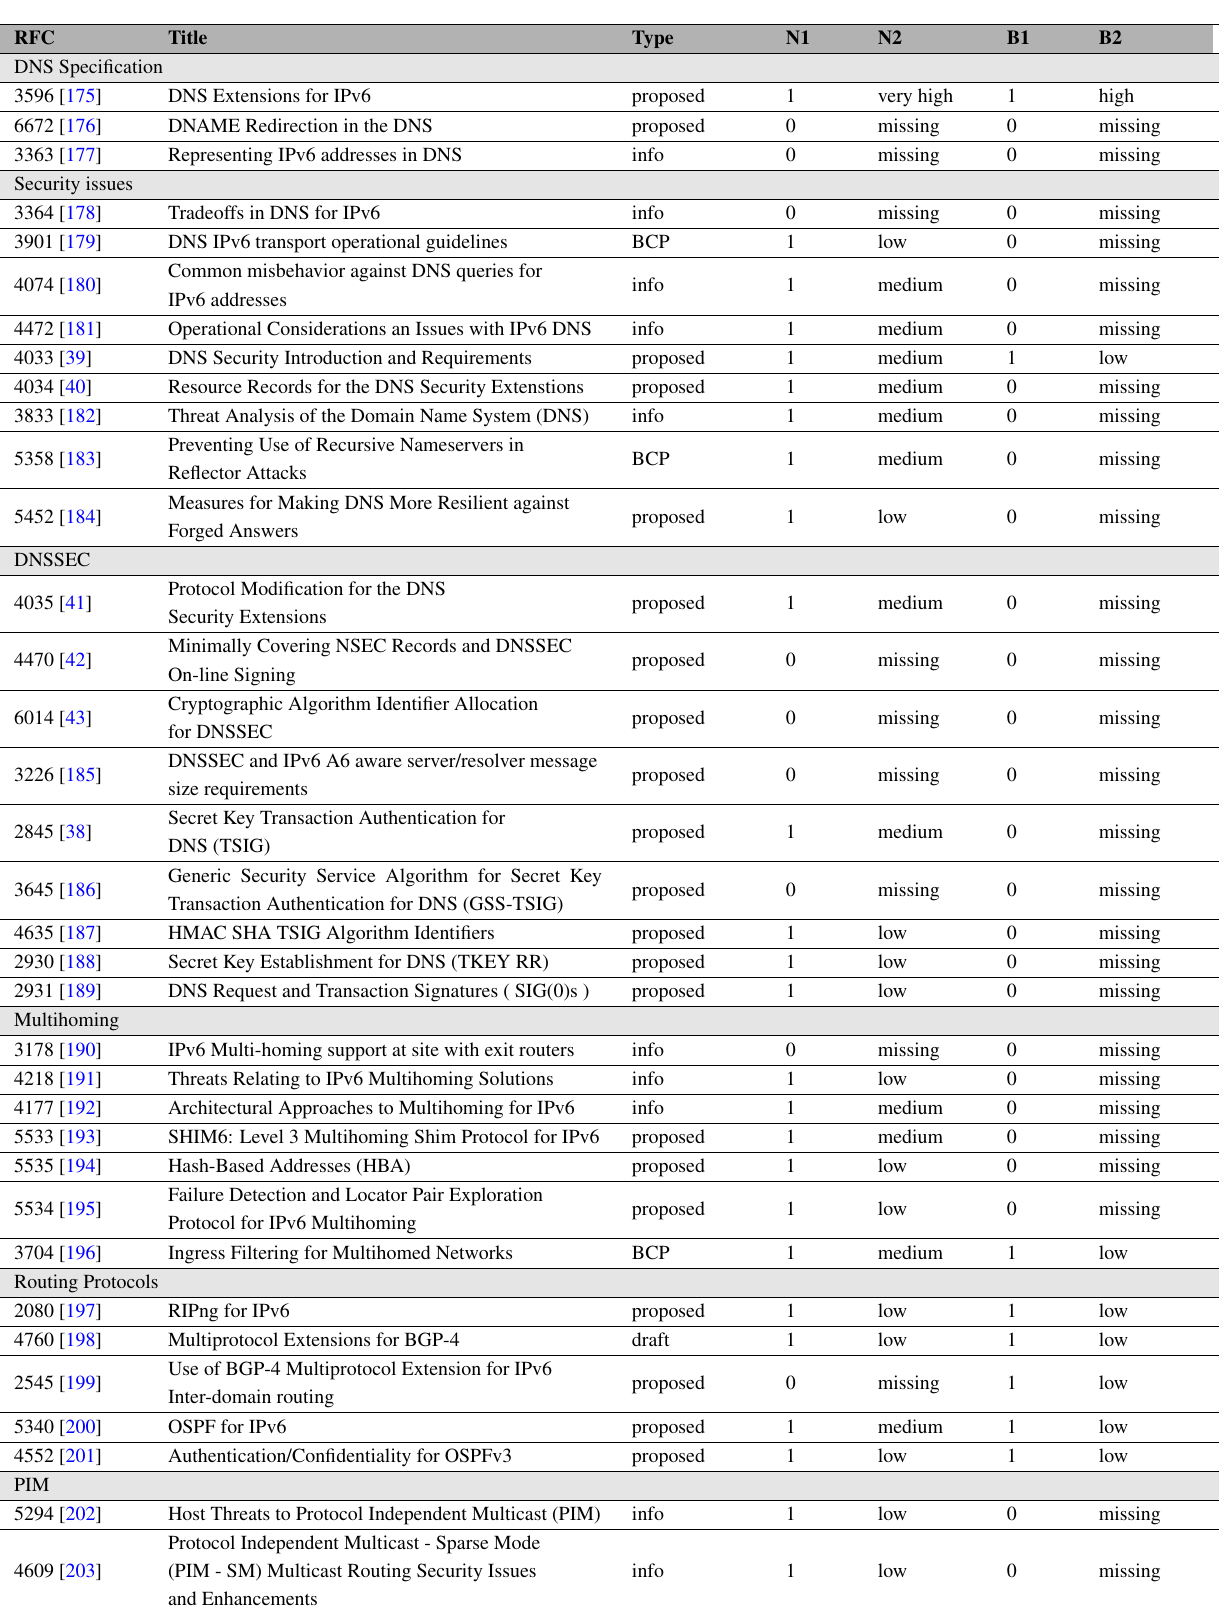
Table A5. RFCs on routing and